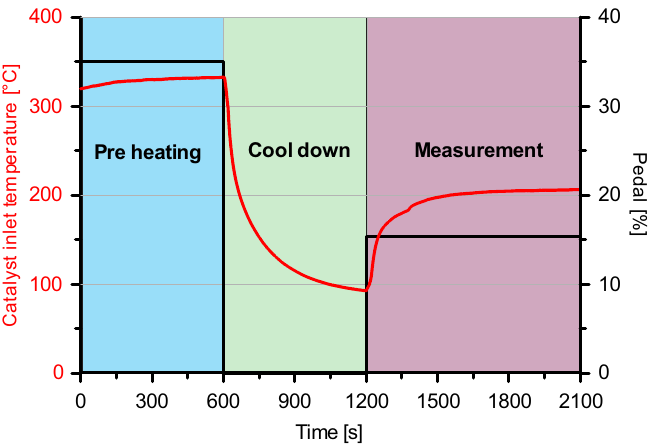
Figure 2. The test procedure for every steady state operating point considered to obtain the CO and HC conversion efficiency contour maps.